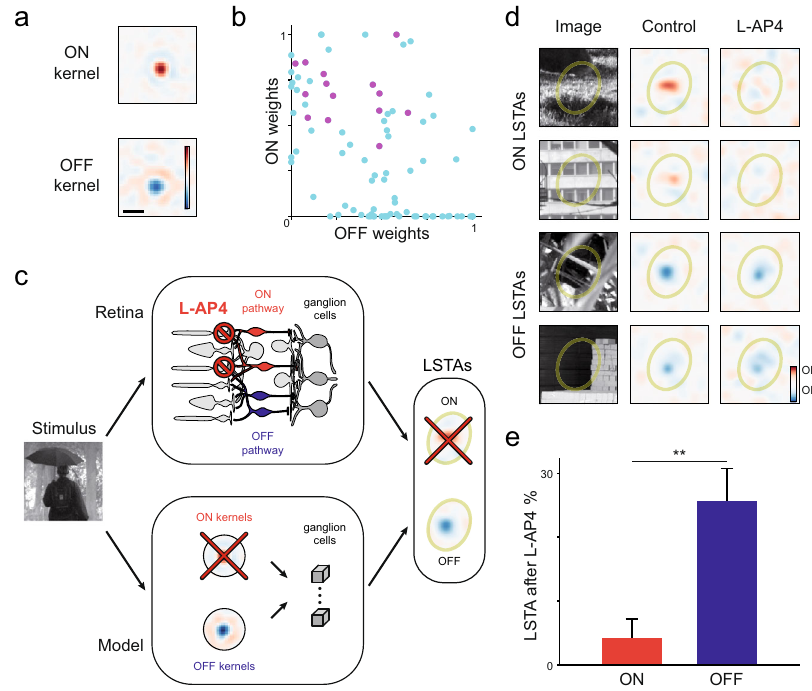
Fig. 3 | ON-OFF pathway convergence onto ganglion cells is needed for LSTA polarity inversion. a Examples of learned convolutional kernels (scale bar: 200 μ m) showing both ON and OFF polarities. All kernels present a strong center and a weakersurround ofthe opposing polarity. The kernels shownhere are taken from mice, asallthe rest of the data inthe fi gure(see SupplementaryFig. 5A,B for more details). b Featureweightsfrom ON(y-axis) and OFF(x-axis) featuremaps for each modeled ganglion cell. Purple: ganglion cell with LSTA polarity inversion. c Schematic showing the model-retina analogy. A stimulus arrives at the fi rst pro- cessing stage of the CNN, the convolutional kernels, which are analogous to the bipolarcellsinthemiddlelayeroftheretina.Informationfromthekernelsispooled by the modeled ganglion cells, or combined into ganglion cells in the output layer of the retina through the ON and OFF pathways. Both modeled and biological ganglioncellscanshowONandOFFLSTAs.Fortheanalogywiththepharmacology experiment, the ON kernels of the model are suppressed (red cross), which